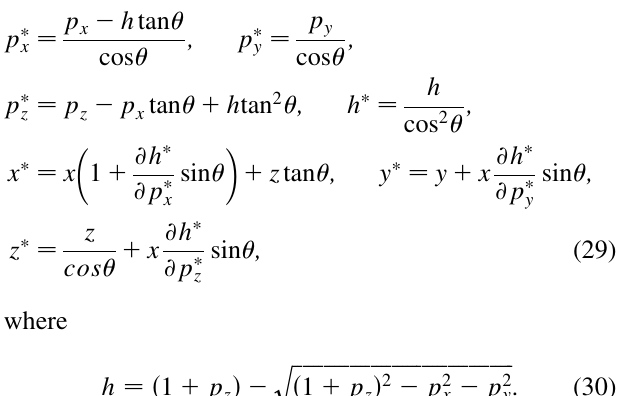
Table I. The design luminosity is 1 : 0 (cid:6) 10 33 cm (cid:5) 2 s (cid:5) 1 at 1.89 GeV.